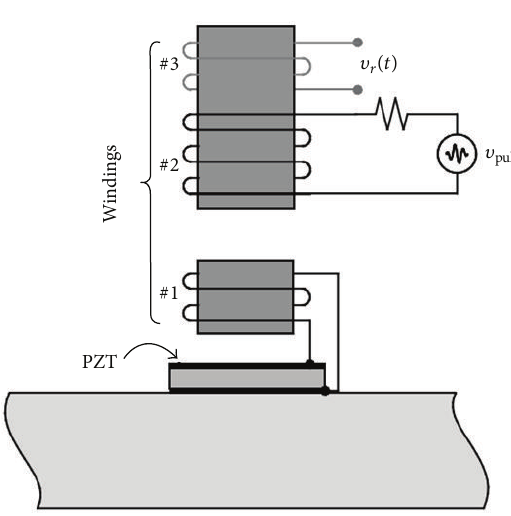
Figure 31: Inductively coupled PZT transducer [25].